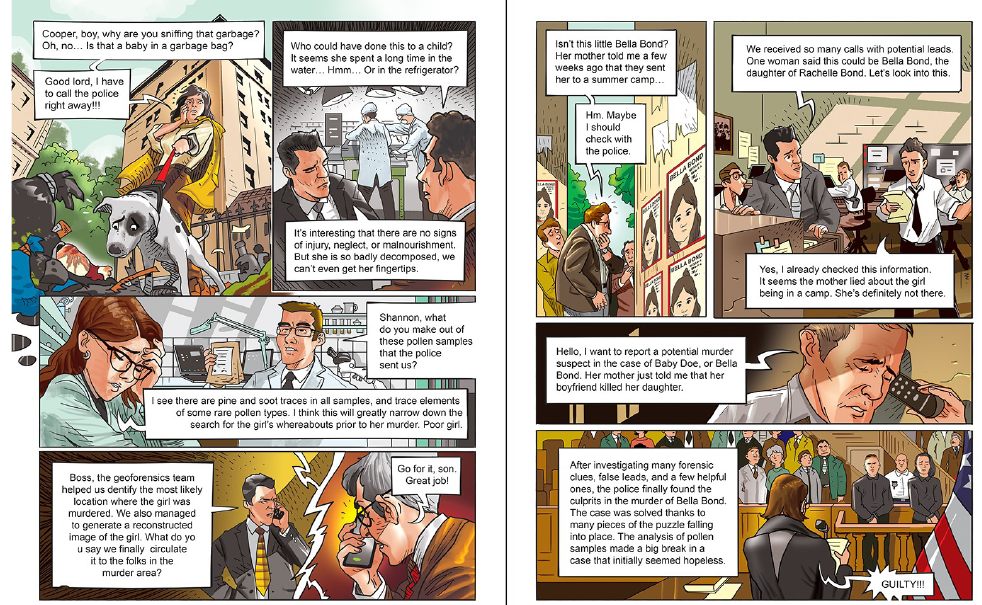
Figure 2. Example of a comic strip used in a language